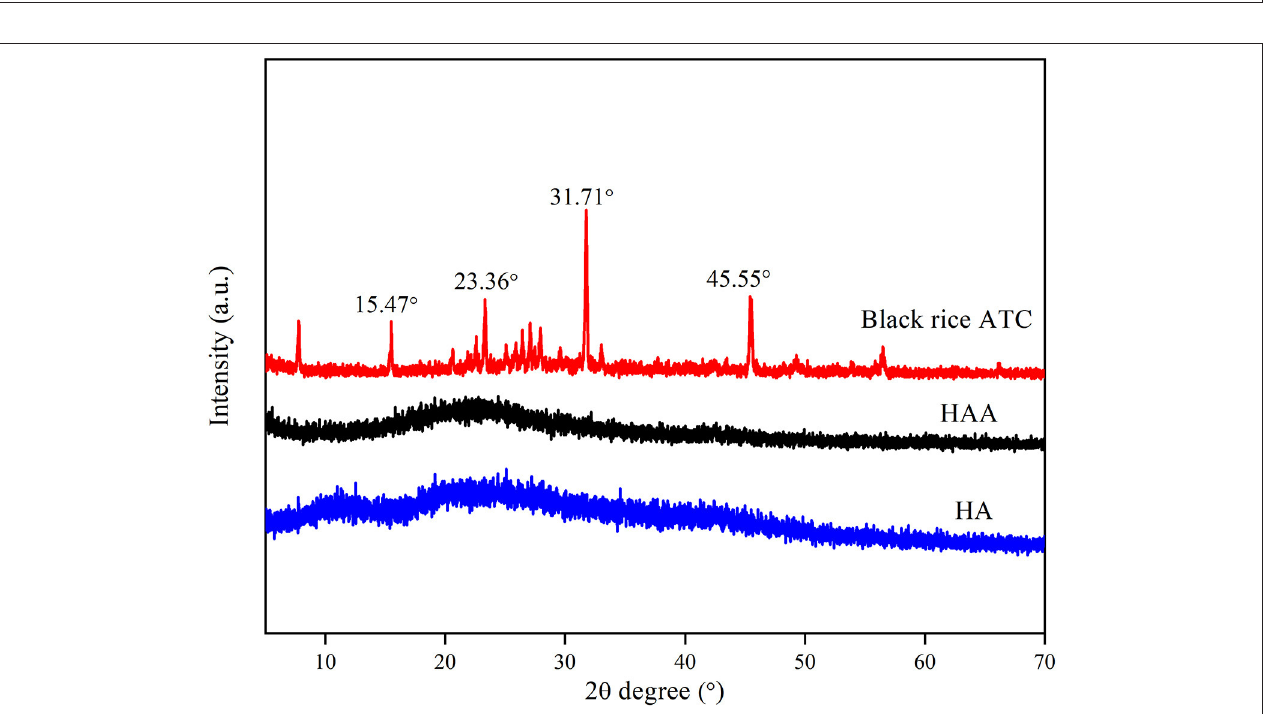
FIGURE 2 | XRD spectra of HA, black rice ATC, and HAA nanocomposite